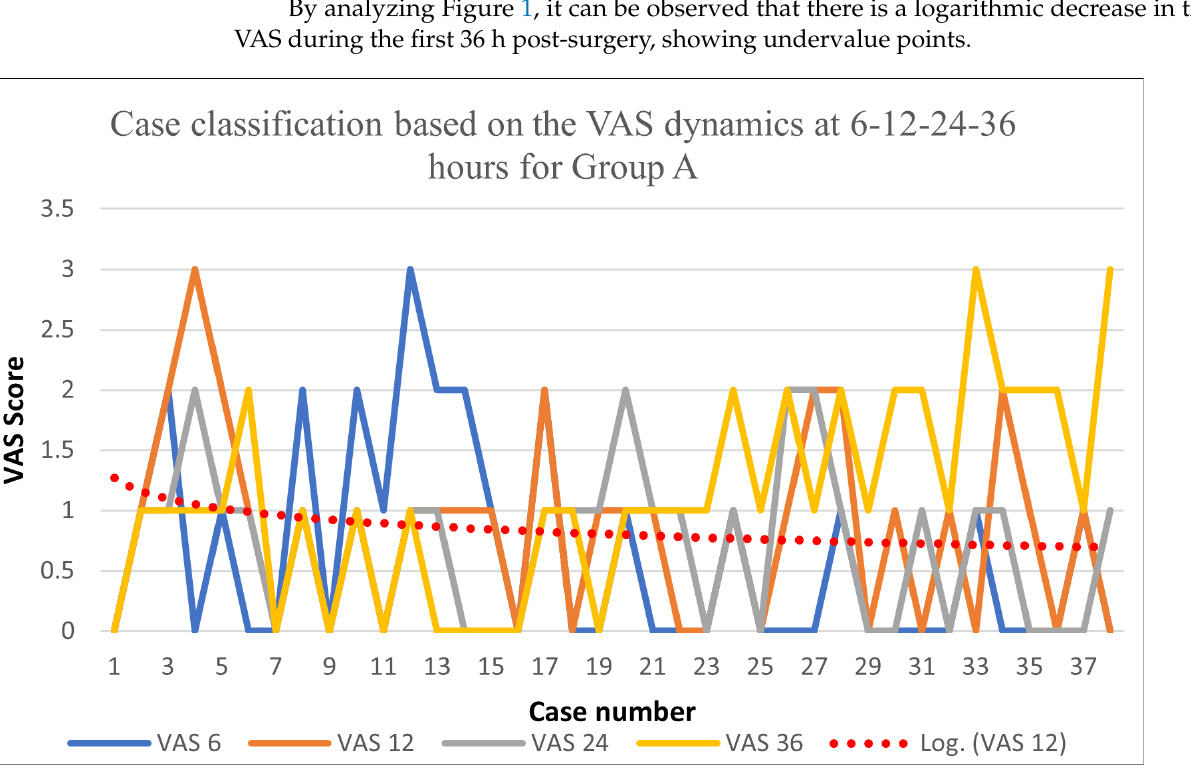
Figure 1. VAS dynamics for Group A.